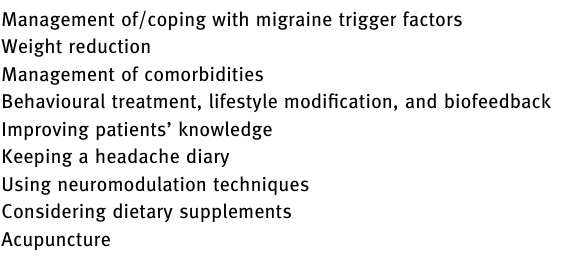
Table 3: Suggested non - pharmacological points for migraine